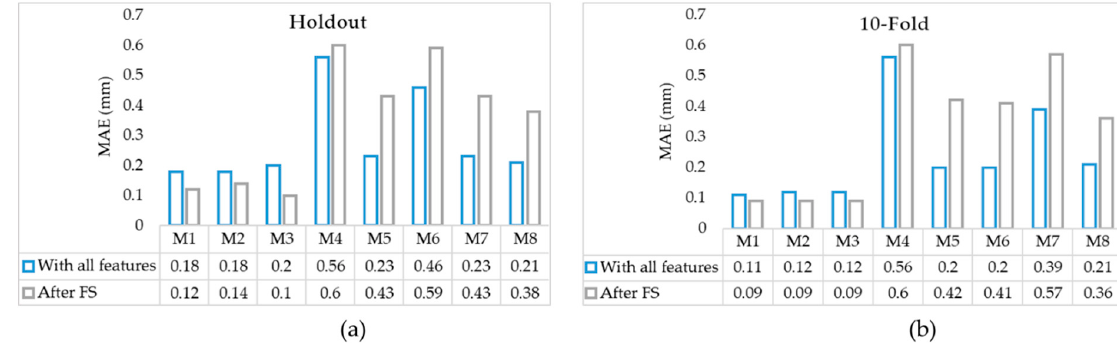
Figure6. MAEswithandwithoutfeatureselectionfor( a )holdoutwith30%and( b )10-foldcross-validation. Figure 6. MAEs with and without feature selection for ( a ) holdout with 30% and ( b ) 10-fold cross- validation.